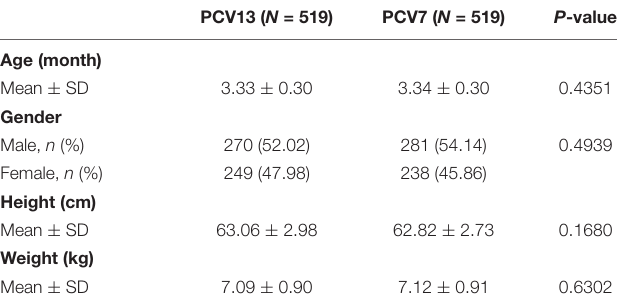
TABLE 1 | Demographics of subjects.